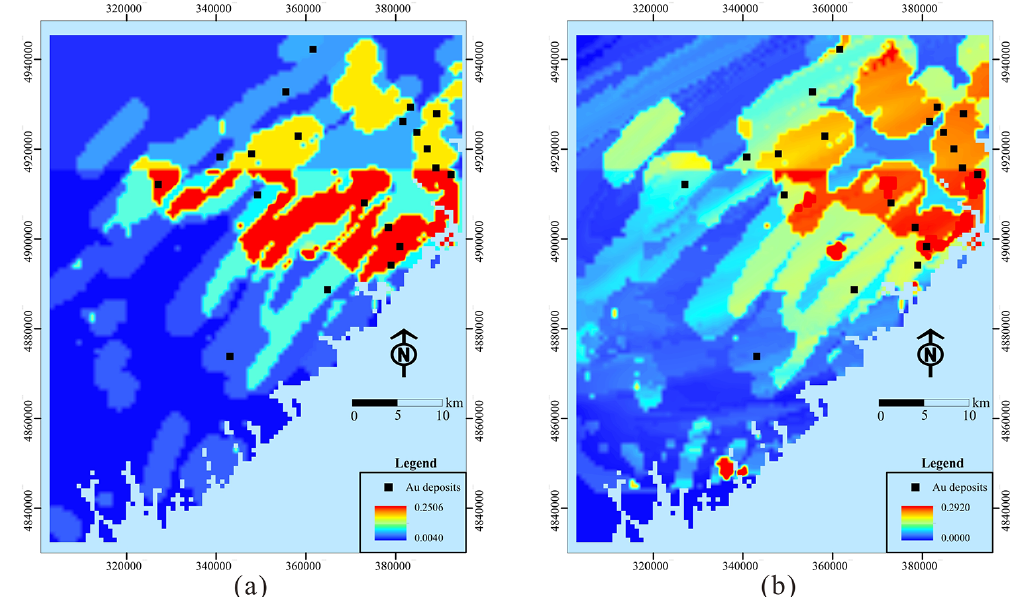
Figure 9. Posterior probability maps obtained for Au deposits by (a) logistic regression and (b) ILRBSWT.